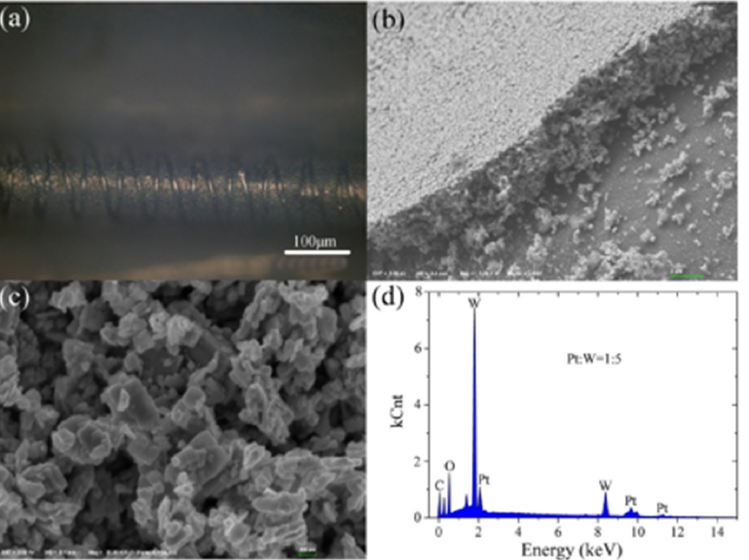
Figure 32. ( a ) Morphology of double spiral microstructure after depositing Pt-WO 3 film. ( b ) The cross-section diagram of Pt-WO 3 film. ( c ) The SEM picture of nanostructure of Pt-WO 3 . ( d ) The en- ergy-dispersive X-ray spectrometer (EDS) pattern of Pt-WO 3 film [136]. Copyright (2017), with per-